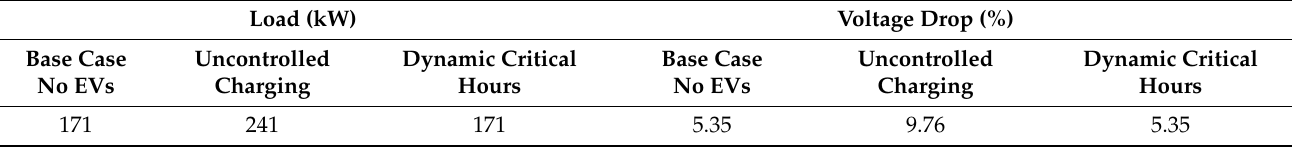
Table 9. Results for Transformer 740/feeder 1 in summer at 60% EVC with/without response to the critical hours. Load (kW) Voltage Drop